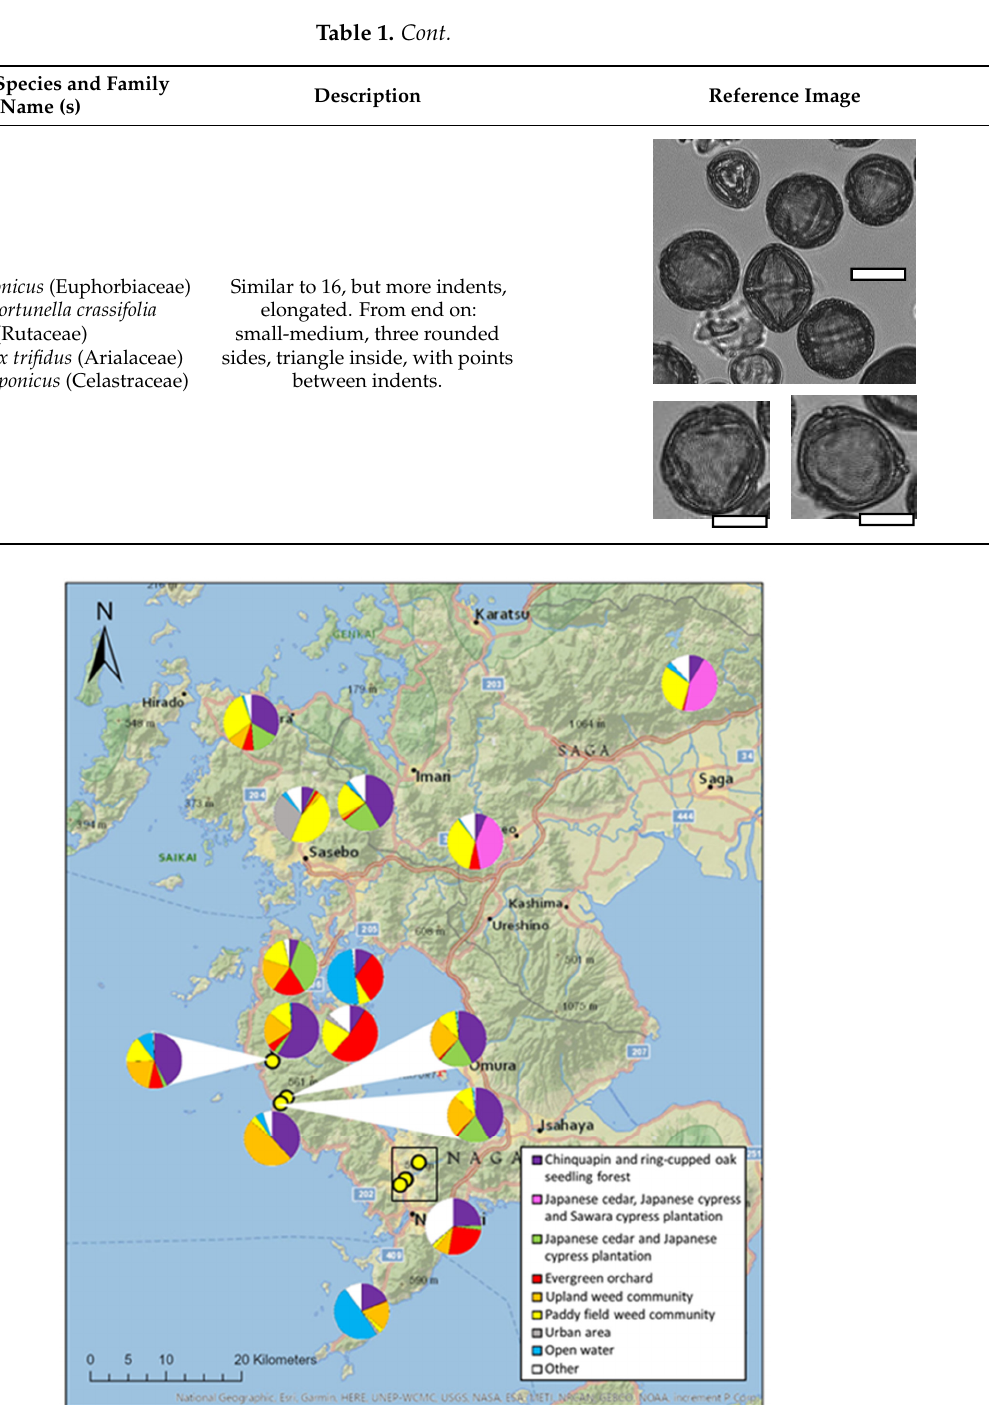
Figure 3. Proportion of land uses in a 1 km radius surrounding 17 hives across Kyushu, Japan. Land uses which were dominant for at least one hive are shown, along with all other land types, grouped into ‘other’. Yellow dots represent hives where pie chart could not be placed directly in the correct location. Hives 2 and 6 as well as 20 and 21 were located in the same apiaries, so are shown using one pie chart per location. Clustered hives in Nagasaki, within the black rectangle, can be found in Supplementary materials. Land use was calculated using vegetation maps freely available from the Japanese Ministry of the Environment’s Biodiversity Centre.